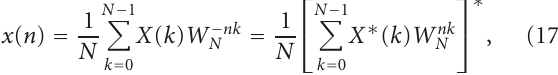
after complex multiplication can estimate the finite precision e ff ect more